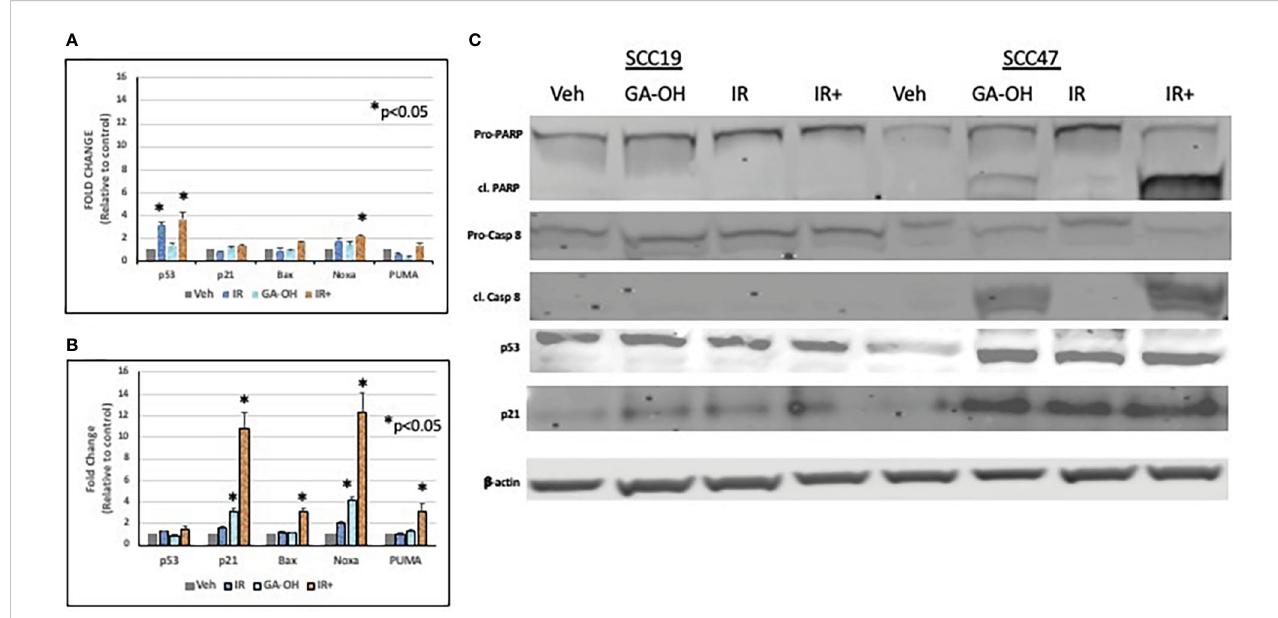
FIGURE 7 Effect of GA-OH and X-ray radiation on apoptotic markers. SCC19 (A) and SCC47 (B) cells were treated with GA-OH radiation for 24 hours and expression of p53 target genes was assessed using qPCR. SCC47 has greater expression of downstream targets of p53 compared to SCC19. (C) Immunoblotting of various p53 target protein molecules and caspase 8 in both SCC19 and SCC47 cells shows more induction of apoptotic markers in SCC47. cl. PARP stands for cleaved PARP; Pro-Casp 8 stands for pro-Caspase 8, cl. Casp 8 stands for cleaved Caspase 8. *, represents statistical signi fi cance of the treatment compared to the vehicle